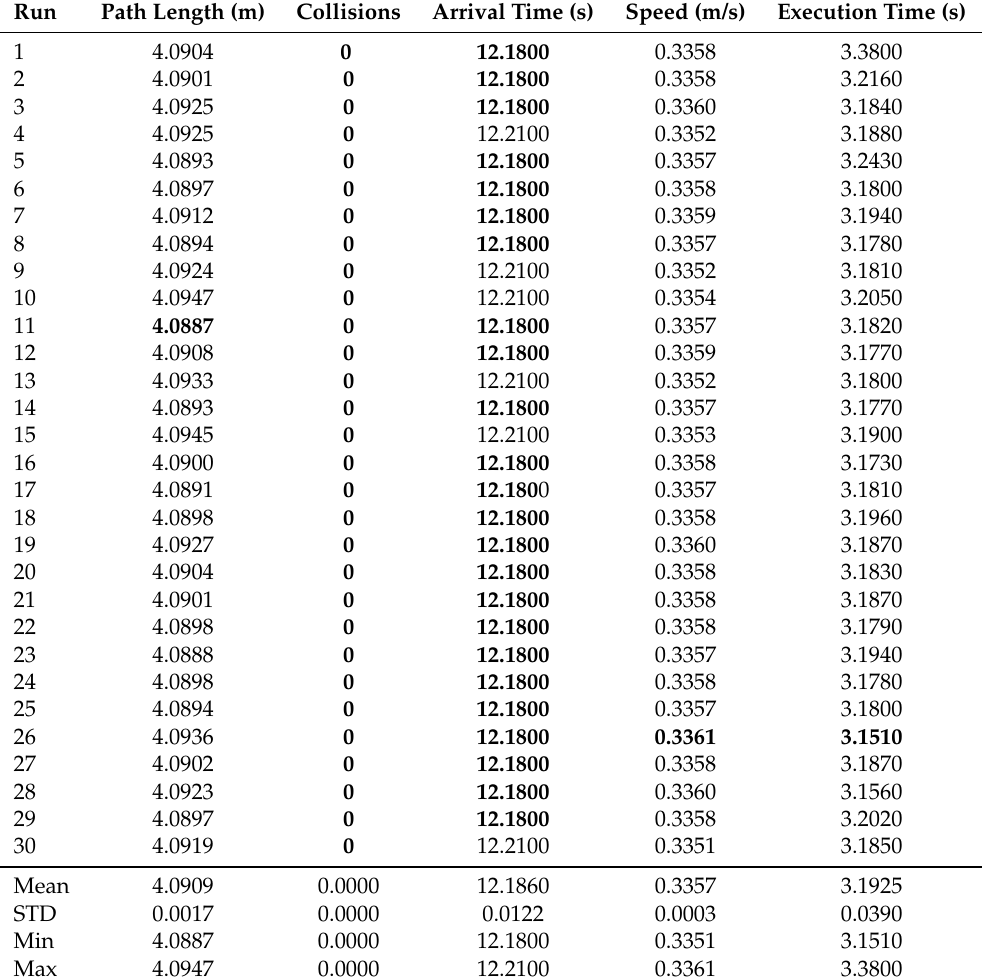
Table 5. Results of D-Bug0/PSO after 30 independent